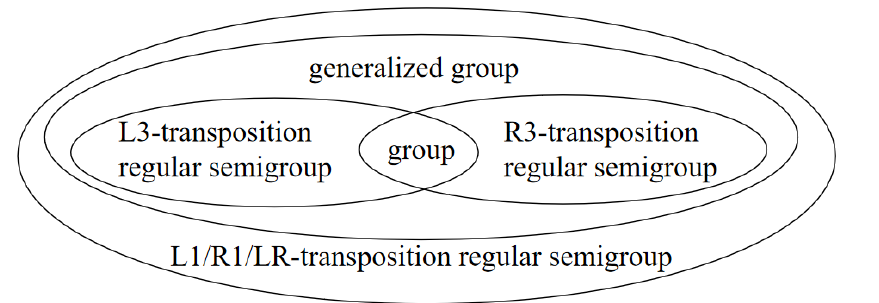
Figure 2. The relationship among various transposition regular